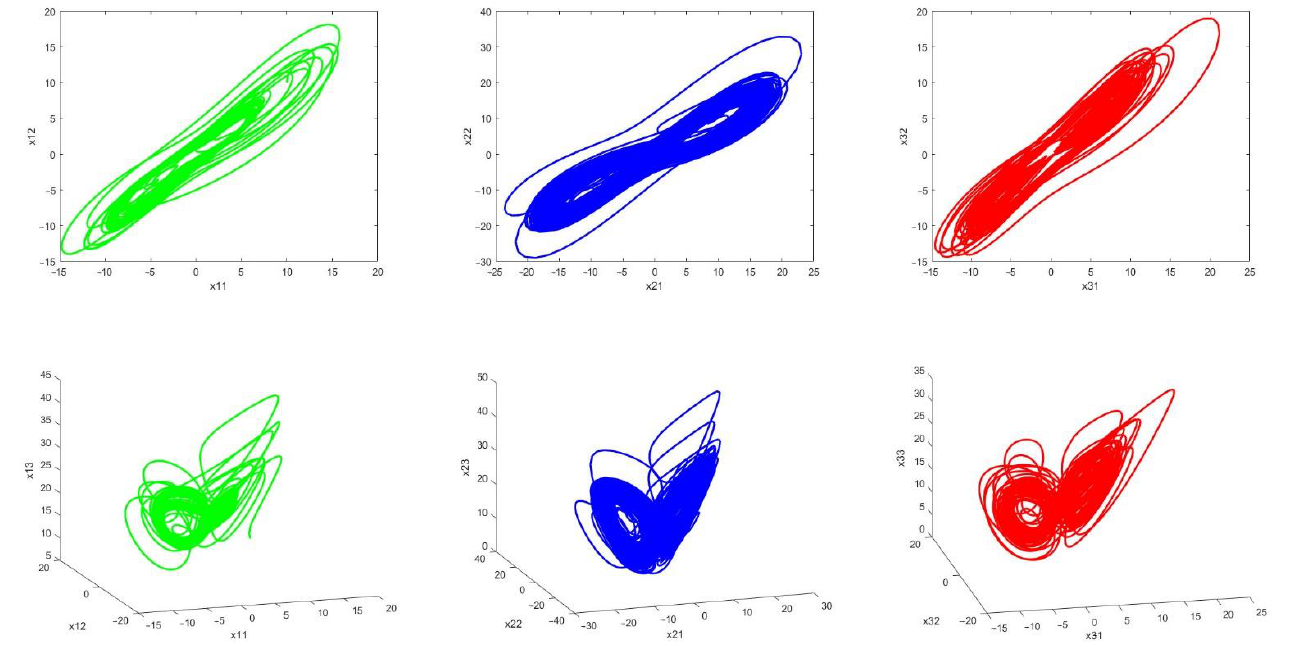
Figure 10. Phase curves for master chaotic system ( green ), Slave 1 ( blue ) and slave 2 ( red ) chaotic systems.